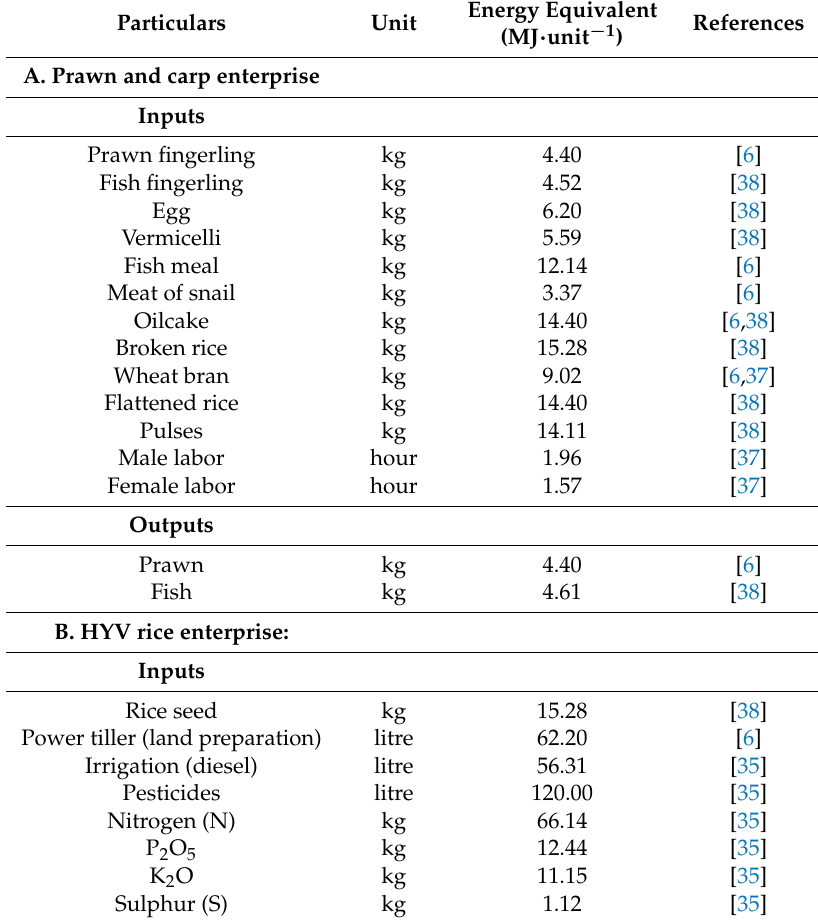
Table 1. Energy coefficients for inputs and outputs of the gher farming system.